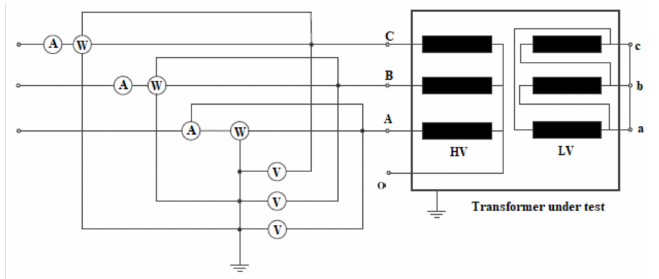
Figure 5. Load loss test arrangement